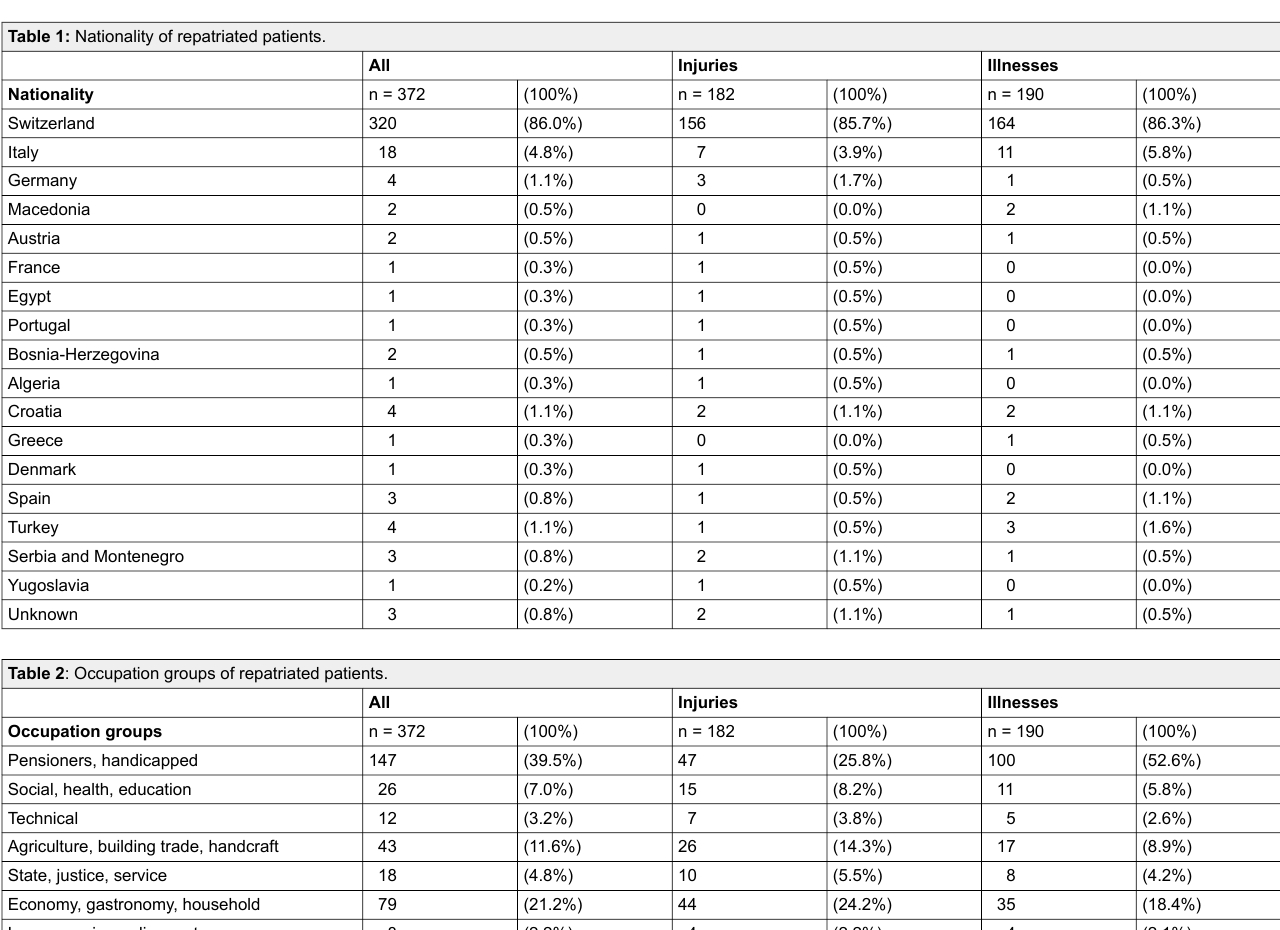
The percentages per country indicate the proportion of repatriated patients to the Inselspital Bern, who were nationals of this country (e.g. 4.9% of repatriated patients were Italians). The colour of the countries indicates the percentage of all repatriations from that country to Inselspital Bern.